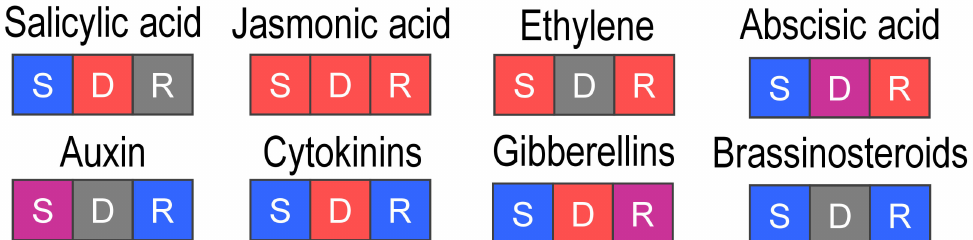
Figure 3. The regulation of Nicotiana tabacum di ff erentially expressed genes (DEGs) related to phytohormone metabolism and signaling during P. atrosepticum -caused infection. S, genes related to synthesis / activation; D, genes related to degradation / inactivation; R, genes related to receptors / signaling. Red box, most DEGs are upregulated; blue box, most DEGs are downregulated; purple box, both up- and downregulated DEGs are well-represented; grey box, genes are non-di ff erentially expressed during the